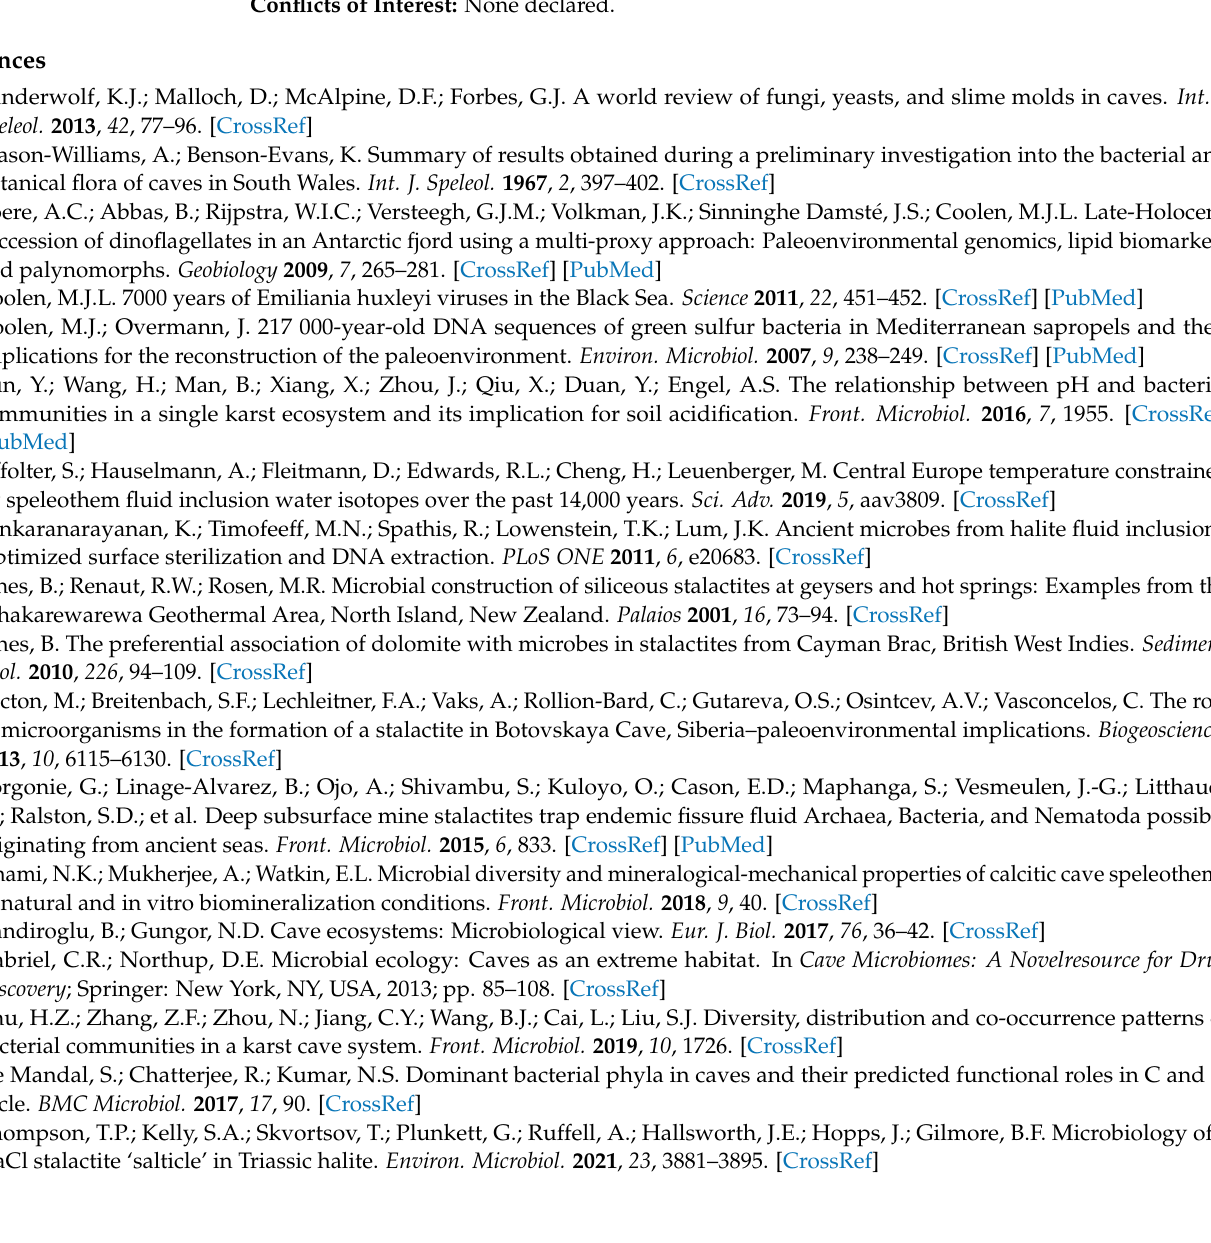
Figure S7: Alpha diversity, Figure S8: Bray-Curtis Heatmap, Figure S9: Venn diagram, Figure S10: Krona pie